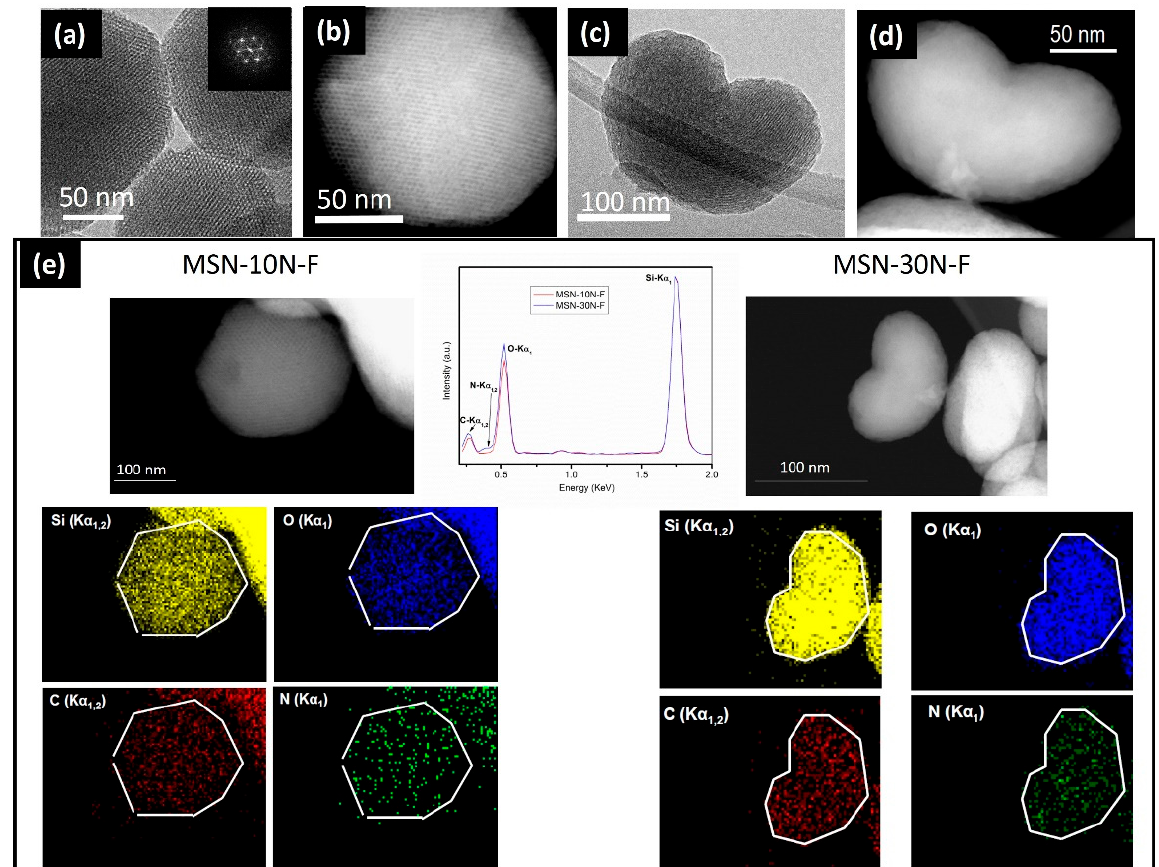
Figure 8. ( a , b ) Characteristic HRTEM and STEM images corresponding to the MSN-10N-F sample; ( c , d ) characteristic HRTEM and STEM images corresponding to the MSN-30N-F sample; ( e ) EDS spectra of MSN-10N-F (left image) and MSN-30N-F (right image) areas and corresponding Si, O, N and C elemental maps (bottom part). Adapted with permission from [43]. Copyright Elsevier (Amsterdam, The Netherlands).